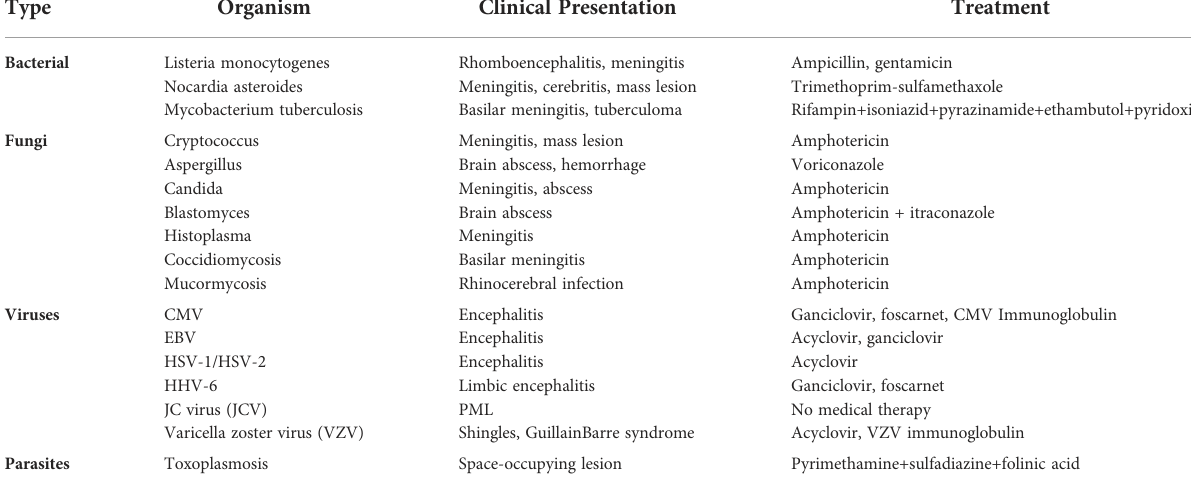
TABLE 2 List of common CNS opportunistic